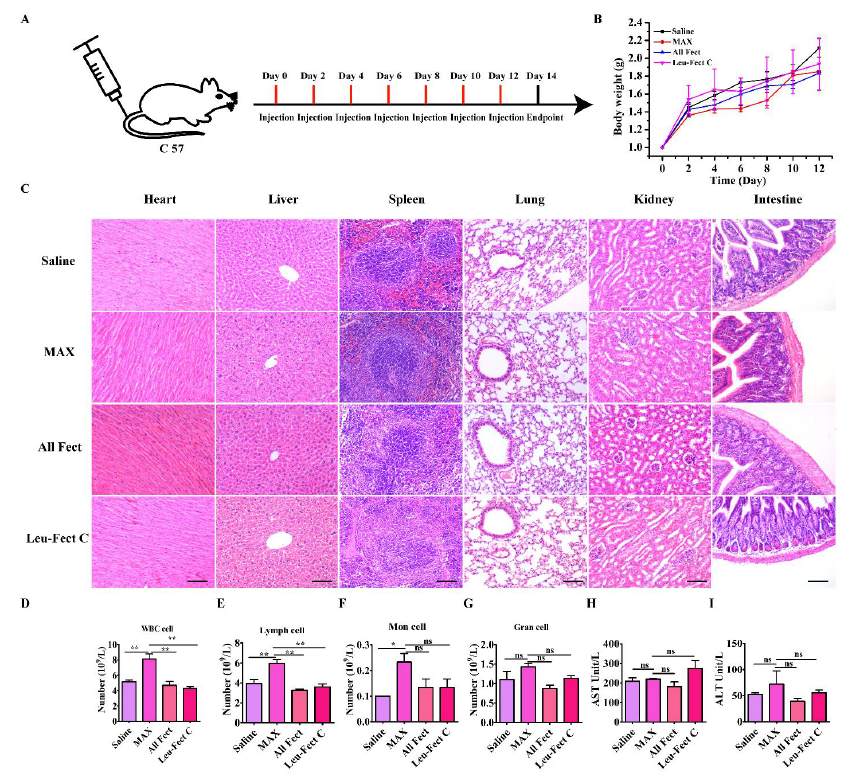
Figure 9. Safety profile analysis of polymeric carriers in vivo. ( A ) Schematic depicting frequency of tail vein injections ( n = 5). ( B ) Growth curve of mouse weight after different days of treatment ( n = 5). ( C ) Histopathological analysis of different organs after systemic delivery of diverse vectors. The scale bar is 100 µm. ( D – I ) Polymeric carrier biosafety profile as assessed 14 days post IV administra- tion using biochemistry analysis of blood samples. (* p < 0.05, ** p < 0.01, ns = not significant).